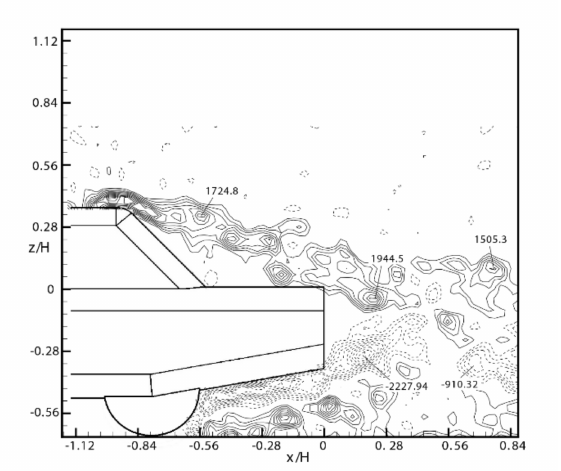
Figure 21. Iso-contours of instantaneous streamwise vorticity, ω y in x–z plane at y/H = 0.28. Minimum and incremental values of vorticity are ω y,min = − 251.519 s − 1 , 407.288 s − 1 and − 1 , ∆ ω y = 235.288 s